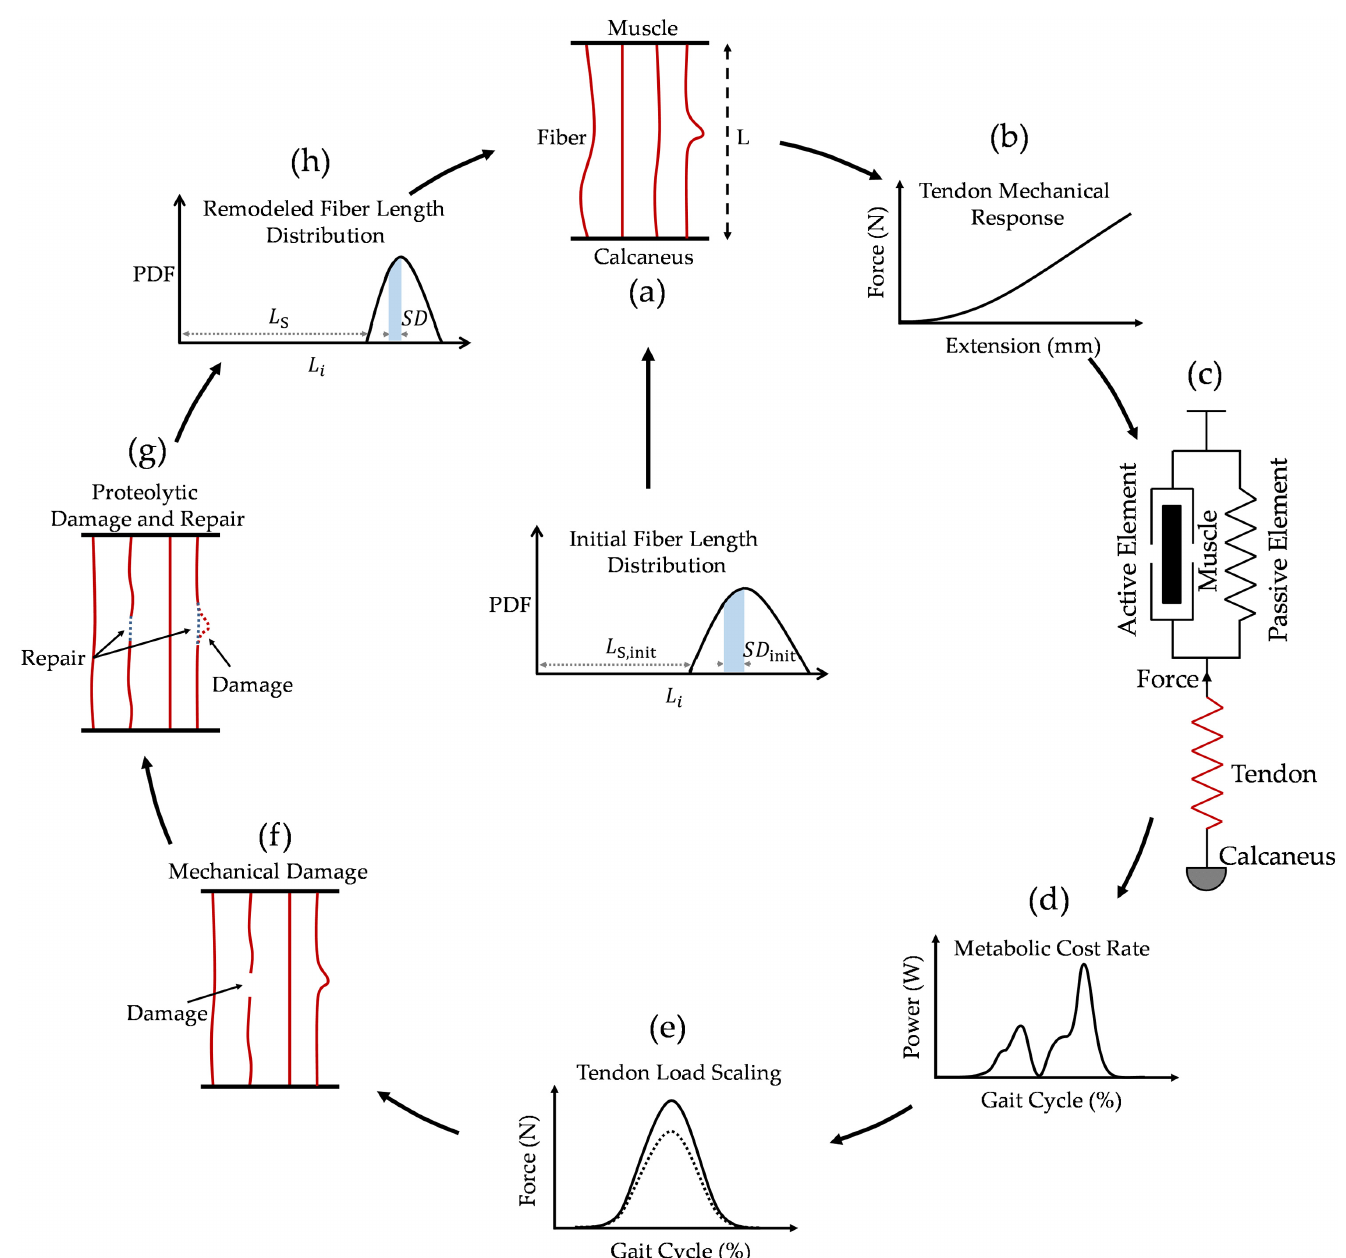
Fig 2. Tendon adaptation modeling cycle. a) discretized tendon model, b) force-extension response of the tendon model, c) three-component Hill musculotendon model, d) metabolic rate calculation model, e) model to scale contractile force from muscle, f) collagen fiber mechanical damage model and, g) collagen fiber proteolytic damage and repair model, h) updated tendon fiber length distribution results in a new tendon configuration and completion of a remodeling cycle of tendon adaptation model. Where PDF is probability density function, L S represents tendon slack length that is equal to the slack length of the shortest fiber, SD represents fiber length standard deviation, a measure of fiber dispersion, and L i represents fiber slack